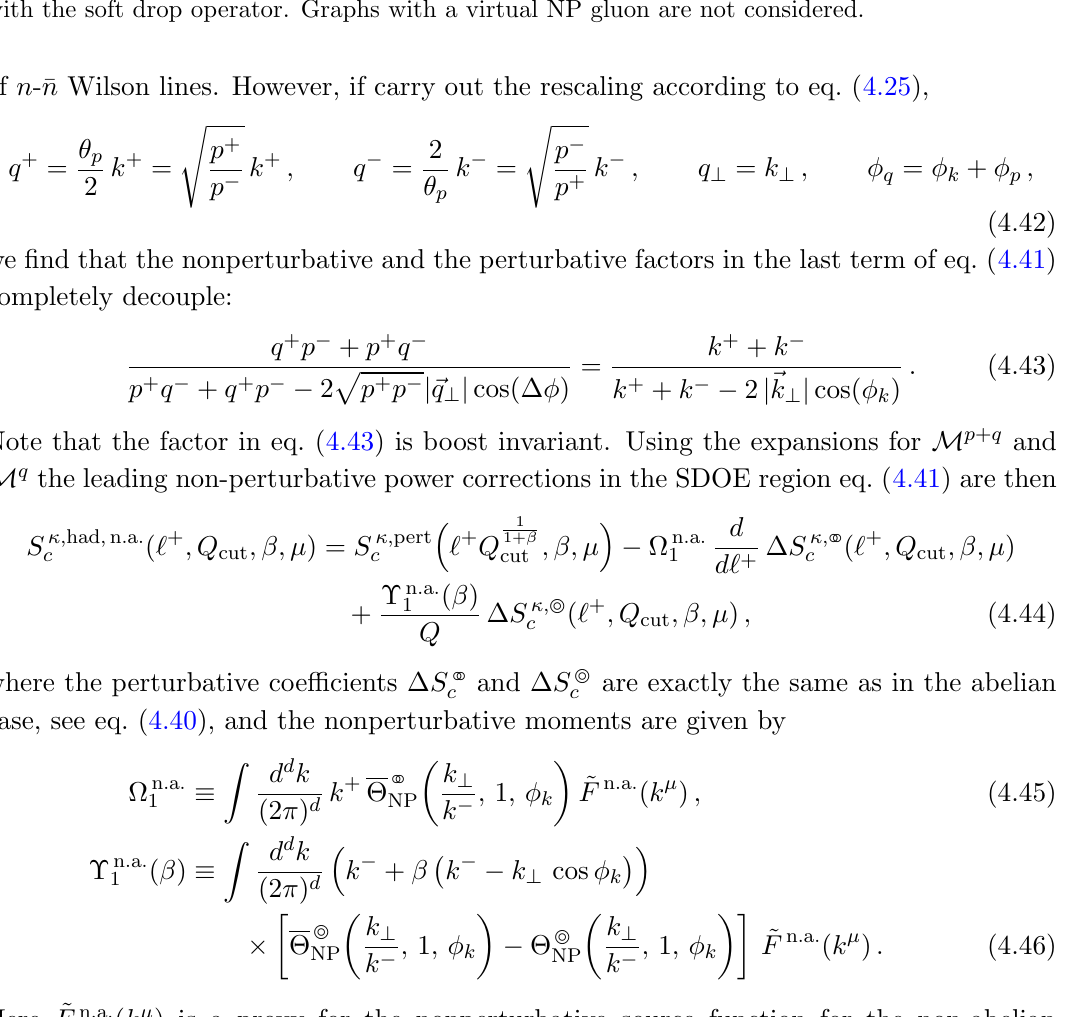
Figure 11 . Examples of non-abelian diagrams with one perturbative (magenta) CS gluon and a nonperturbative (brown) gluon. Dashed line represents measurement of the plus momentum along with the soft drop operator. Graphs with a virtual NP gluon are not